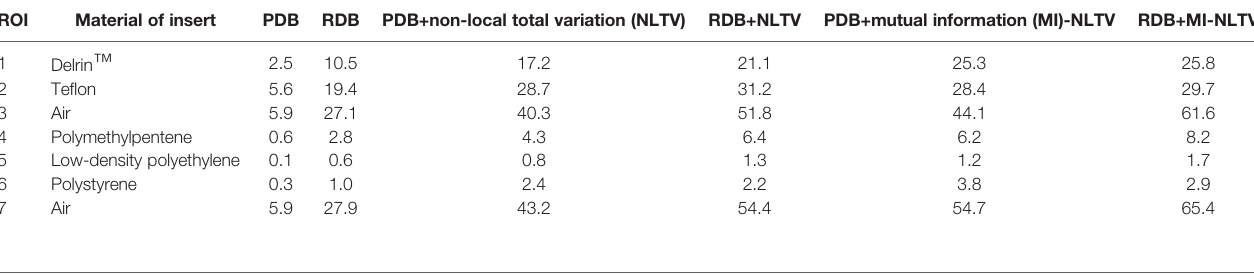
TABLE 1 | Comparison of contrast-to-noise ratio (CNR) values at seven ROIs in the CBCT image generated by analytical reconstruction algorithms based on Pixel- driven backprojector (PDB) and Ray-driven backprojector (RDB) using low-dose projection data of the Catphan ® 503 phantom. ROI Material of insert